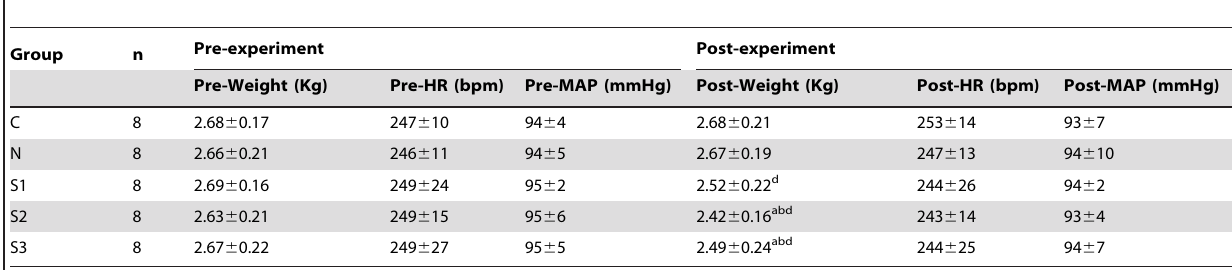
Table 1. The comparison of weight (kg), heart rate (bpm) and mean arterial pressure (mmHg).